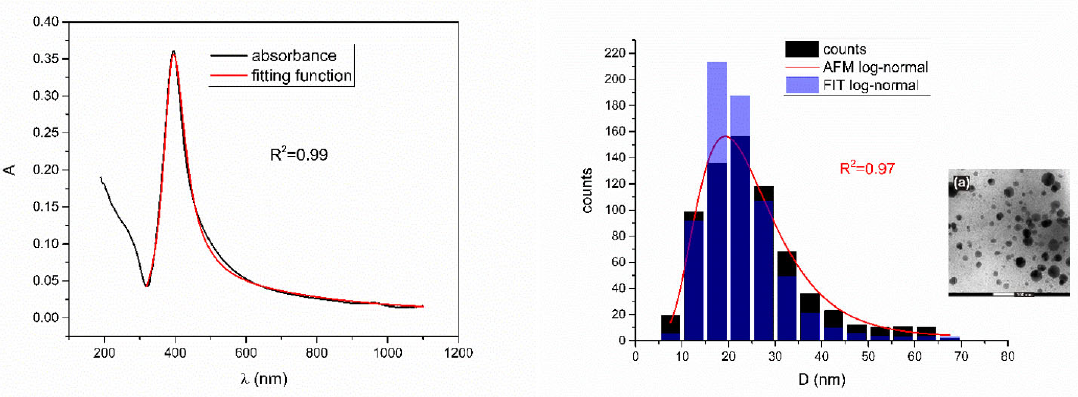
Figure 5. UV ‐ Vis spectrum with fitting function ( left ) for sample Ag_5. Reported and reconstructed size distributions are shown on the ( right) . An additional TEM image is also shown.